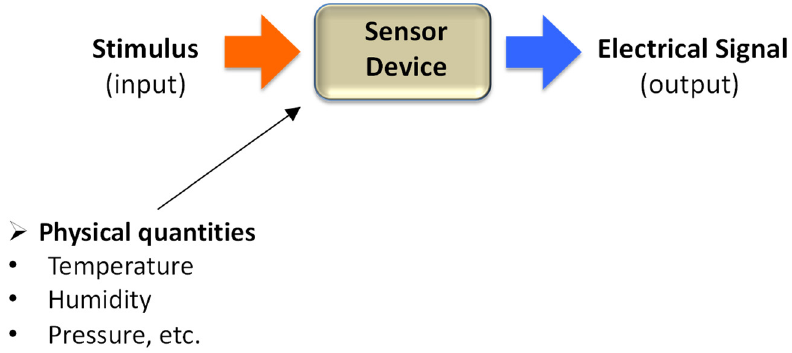
Figure 1. Schematic representation of a sensor’s functioning.